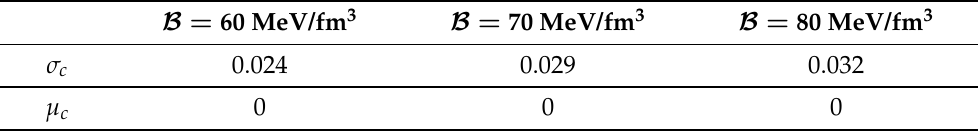
Table 1. Initial conditions corresponding to solution I for different values of the bag constant corresponding to Υ = 0.2,